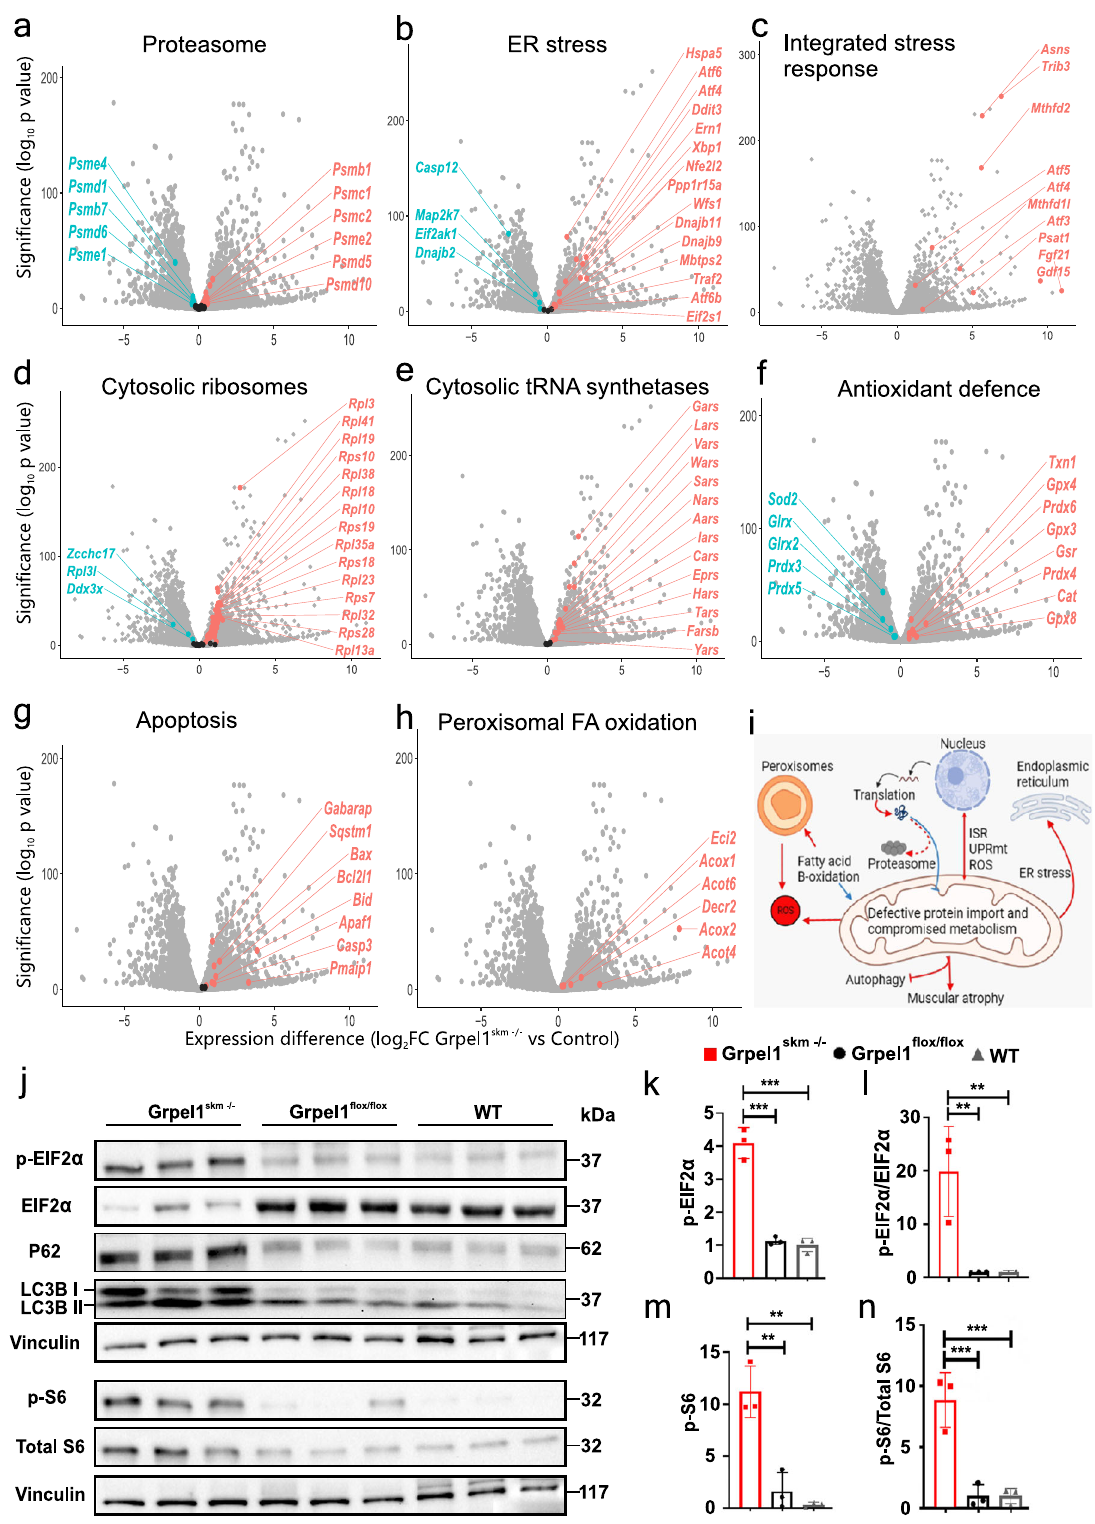
Fig. 3 Organelle crosstalk in response to Grpel1 loss in skeletal muscle. a – h Volcano plots for different pathways indicating changes in gene expression due to loss of Grpel1 in skeletal muscle. i Graphical representation of crosstalk between dysfunctional mitochondrial, due to loss of Grpel1 , with other cellular organelles. Red color (arrows) indicates upregulation whereas the blue color (arrows) indicates downregulation (Created with BioRender.com). j Immunoblot of total protein lysates from QF muscle of Grpel1 skm − / − , Grpel1 fl ox/ fl ox and WT mice. k – n Quanti fi cation of p-EIF2 α level, p-EIF2 α /total EIF2 α ratio, p-S6 level and p-S6/total S6 ratio in skeletal muscle of Grpel1 skm − / − , Grpel1 fl ox/ fl ox and WT mice. Vinculin was used as the loading control ( n = 3 per